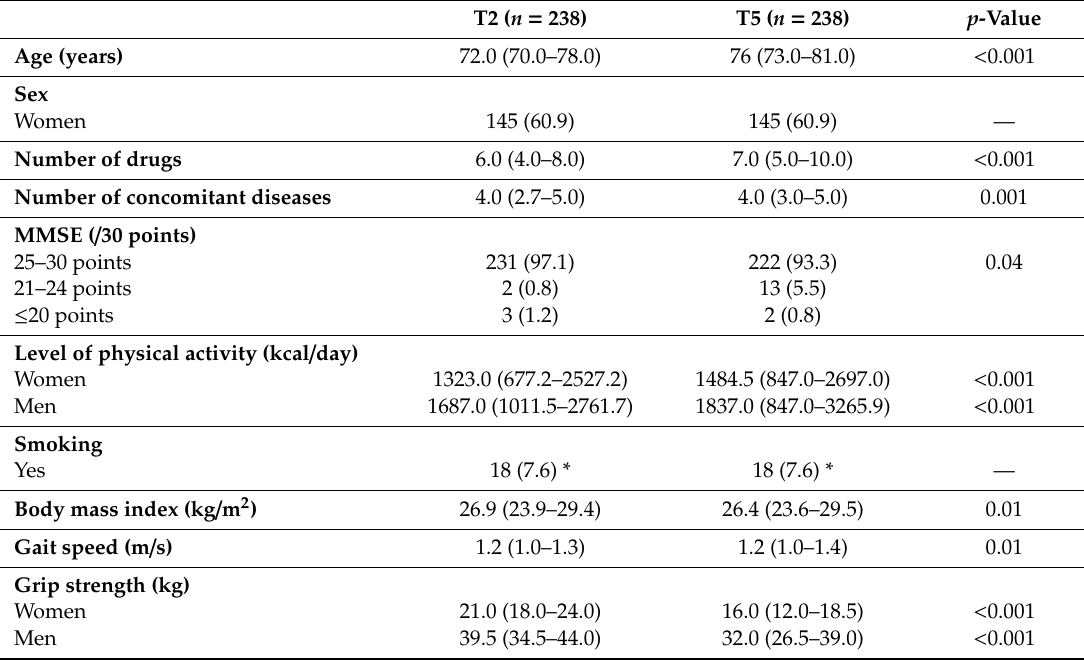
Figure 1. Flow chart. Table 1. Socio-demographic and clinical characteristics of participants at inclusion (T2) and after three years of follow-up (T5).